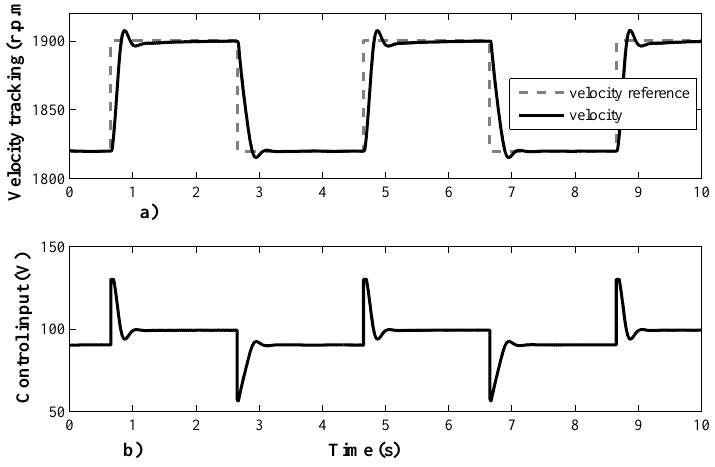
Figure 3. Proportional-integral ( PI ) controller. ( a ) Velocity tracking, and ( b ) control input u a .